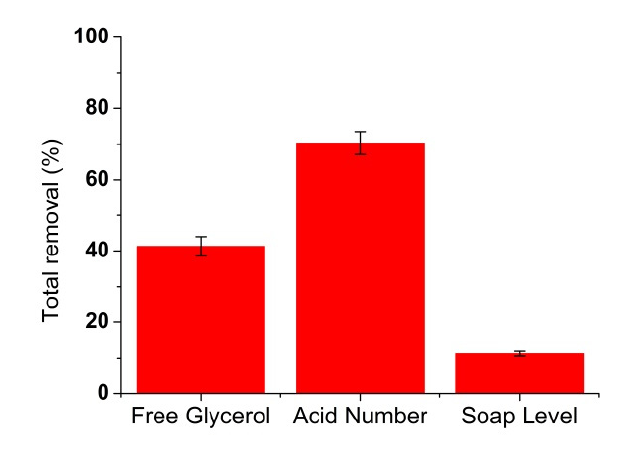
Figure 10. The total removal contaminants in biodiesel by the IOCM of chitosan–silica in the dead-end filtration process.